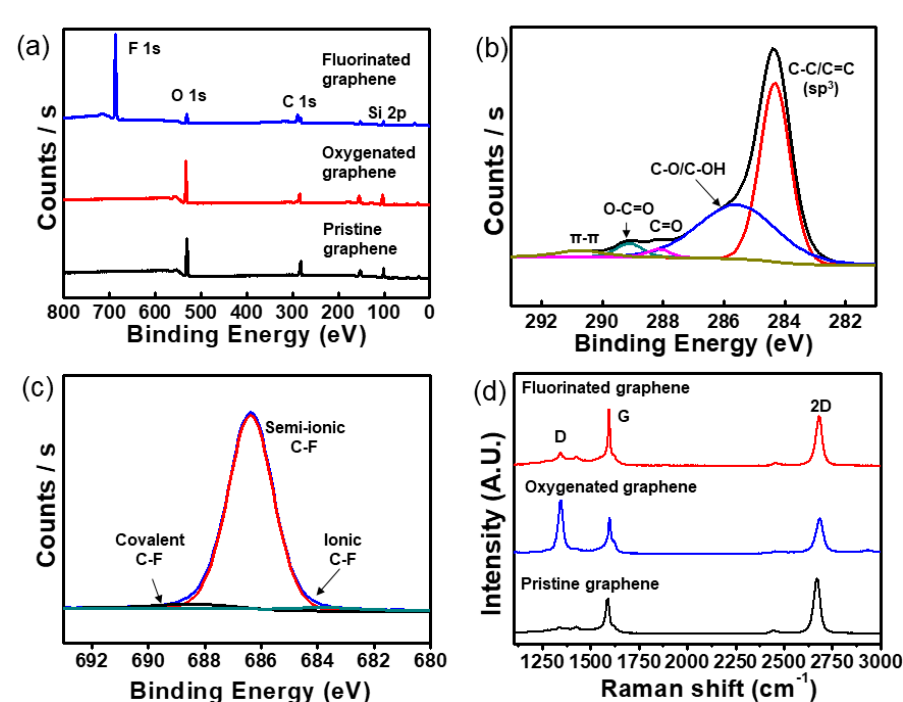
Figure 1. XPS and Raman spectra of graphene. ( a ) Survey spectra of XPS on pristine, oxygenated and fluorinated graphene; ( b ) deconvoluted C 1s peaks on partially oxygenated graphene; ( c ) deconvoluted F 1s peaks on partially fluorinated graphene; ( d ) Raman spectra of pristine, oxygenated and fluorinated graphene.